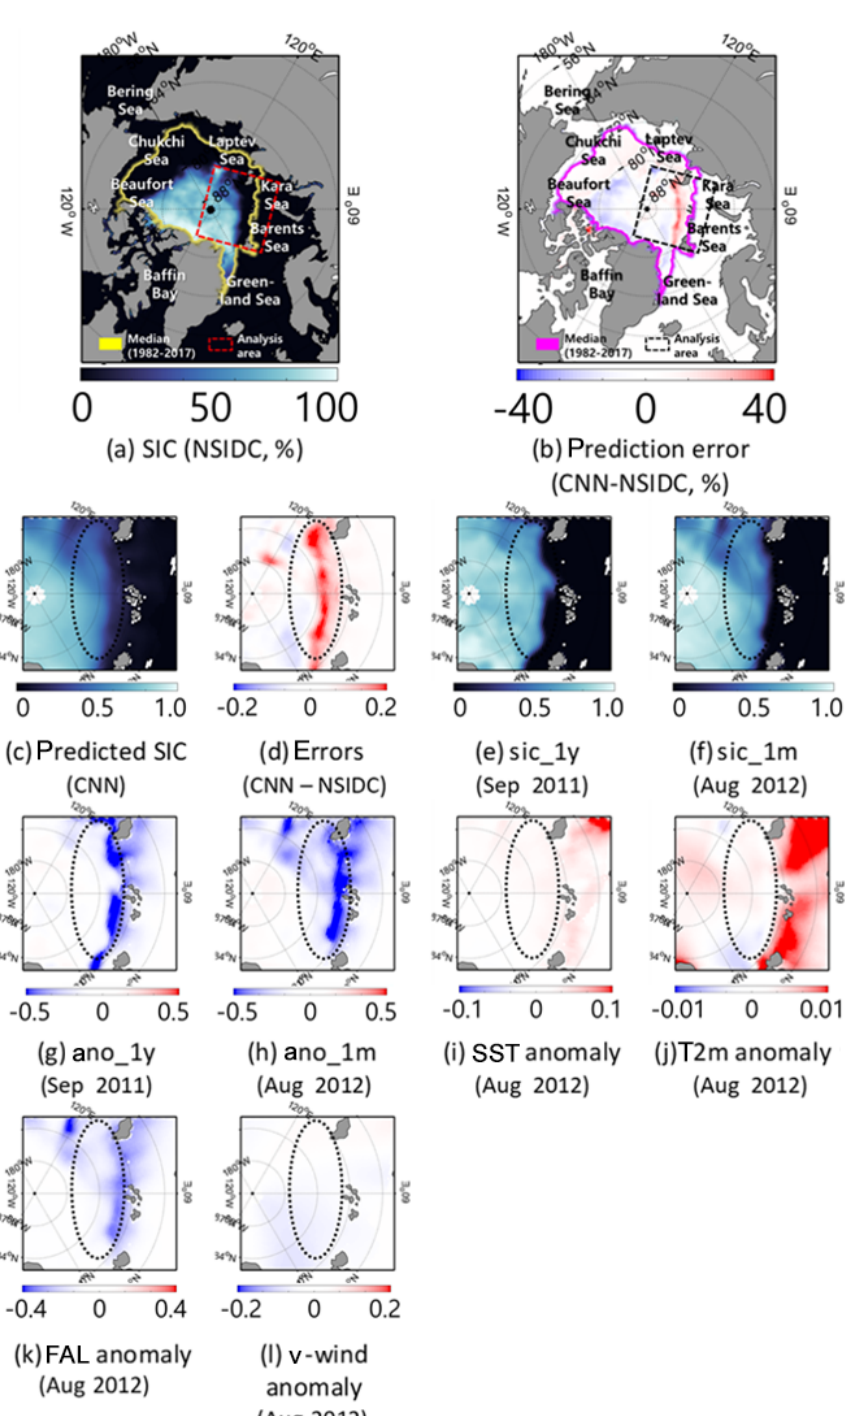
Figure 11. Comparison of the prediction results of both models with eight input variables in the Barents Sea–Kara Sea in September 2012. The dotted black circle is the region showing higher prediction